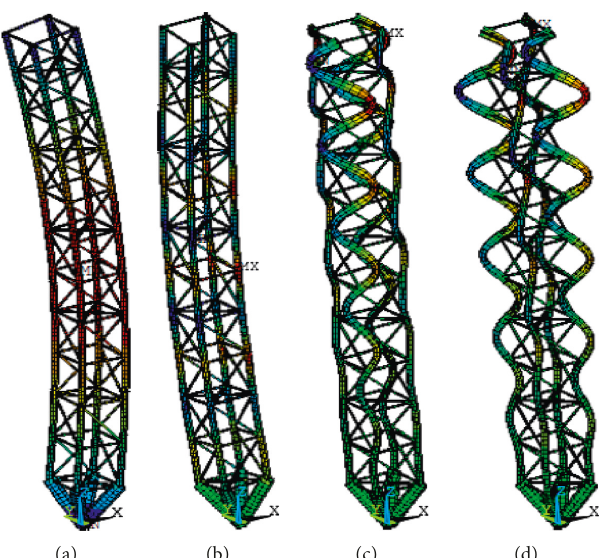
Figure 7: First four buckling modes. (a) First buckling mode. (b) Second buckling mode. (c) Third buckling mode. (d) Fourth buckling